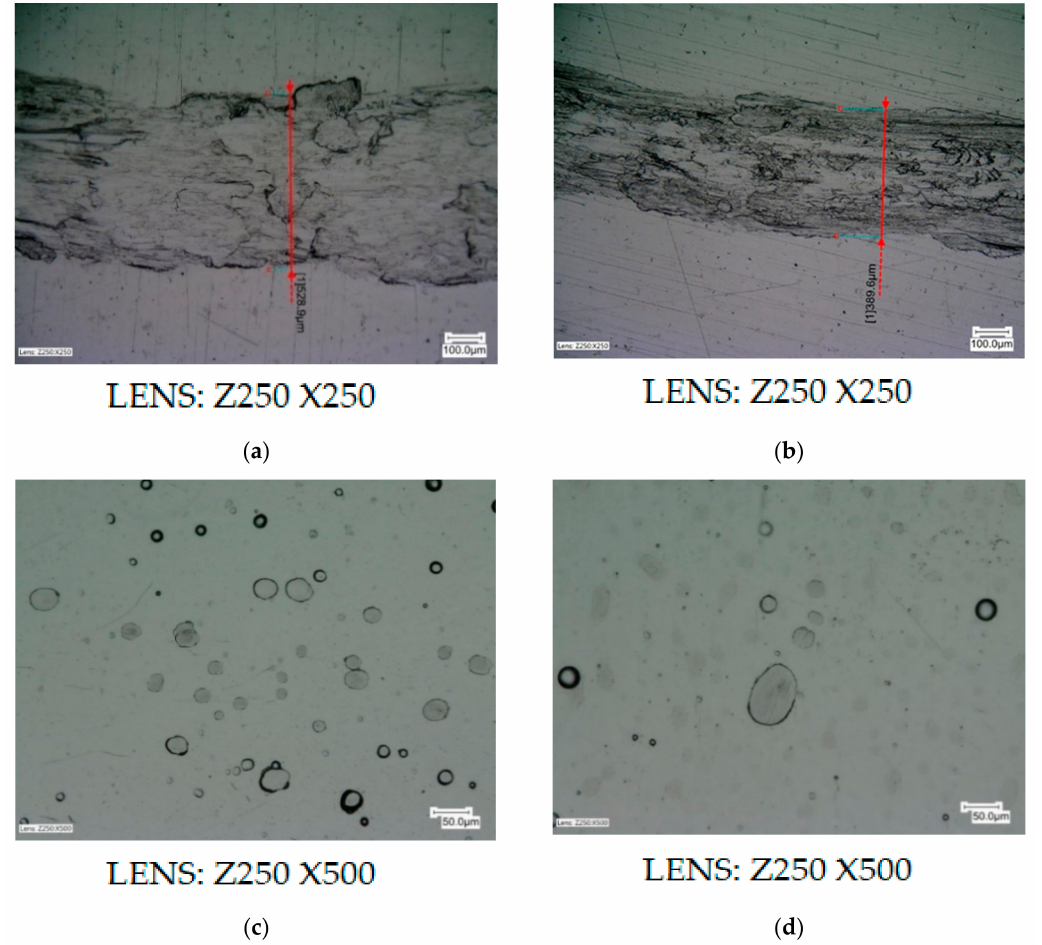
Figure 7. Samples of alloy AW-7075 without coatings and with Ni-P / Si 3 N 4 layers. (( a )—AW-7075 without grease; ( b )—AW-7075 with MoS 2 grease; ( c )—Ni-P / Si 3 N 4 (2g) with MoS 2 grease; ( d )—Ni-P / Si 3 N 4 (5g) with MoS 2 grease; crack widths ( µ m): ( a )—528.9, ( b )—389.6, ( c )—no scratches, ( d )—no scratches).